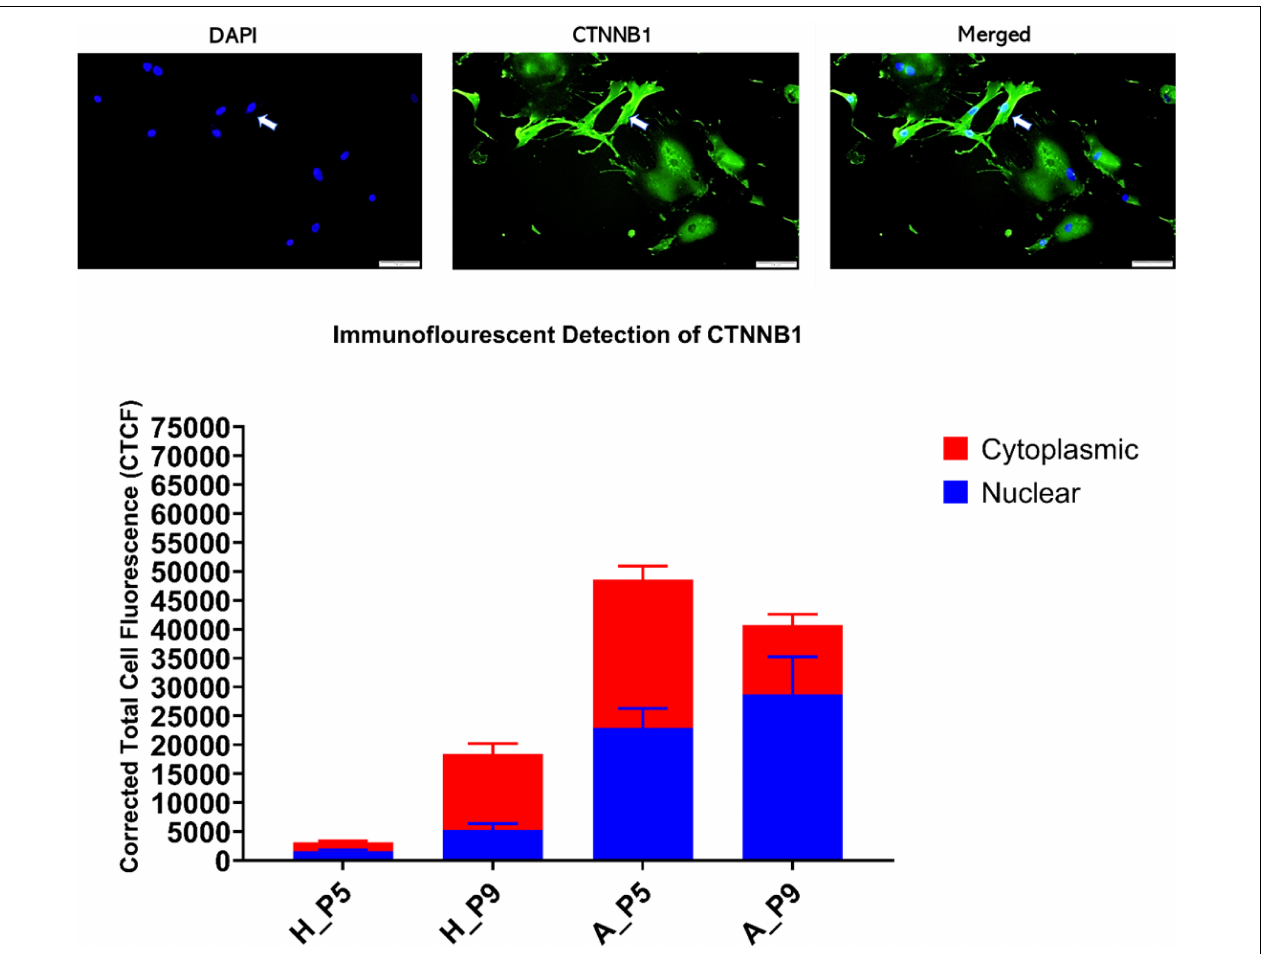
FIGURE 10 | CTNNB1 subcellular localization and fractionation in primary bronchial fibroblasts from healthy and asthmatic patients. Immunofluorescent cellular localization of CTNNB1 as corrected total cell fluorescent (CTCF) of 10 random spots in the cytoplasm compared to 10 different fields in the